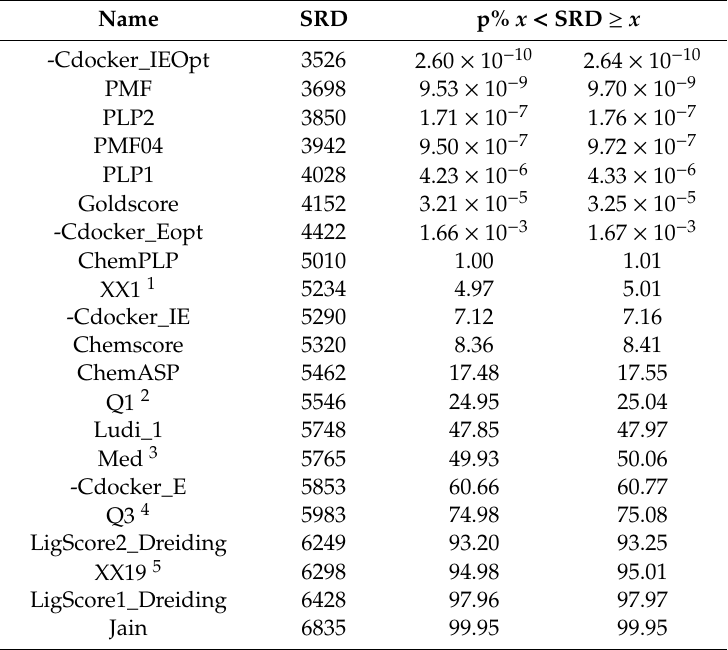
Table 12. SRD ranking of the 16 fitness functions used in the GOLD run.